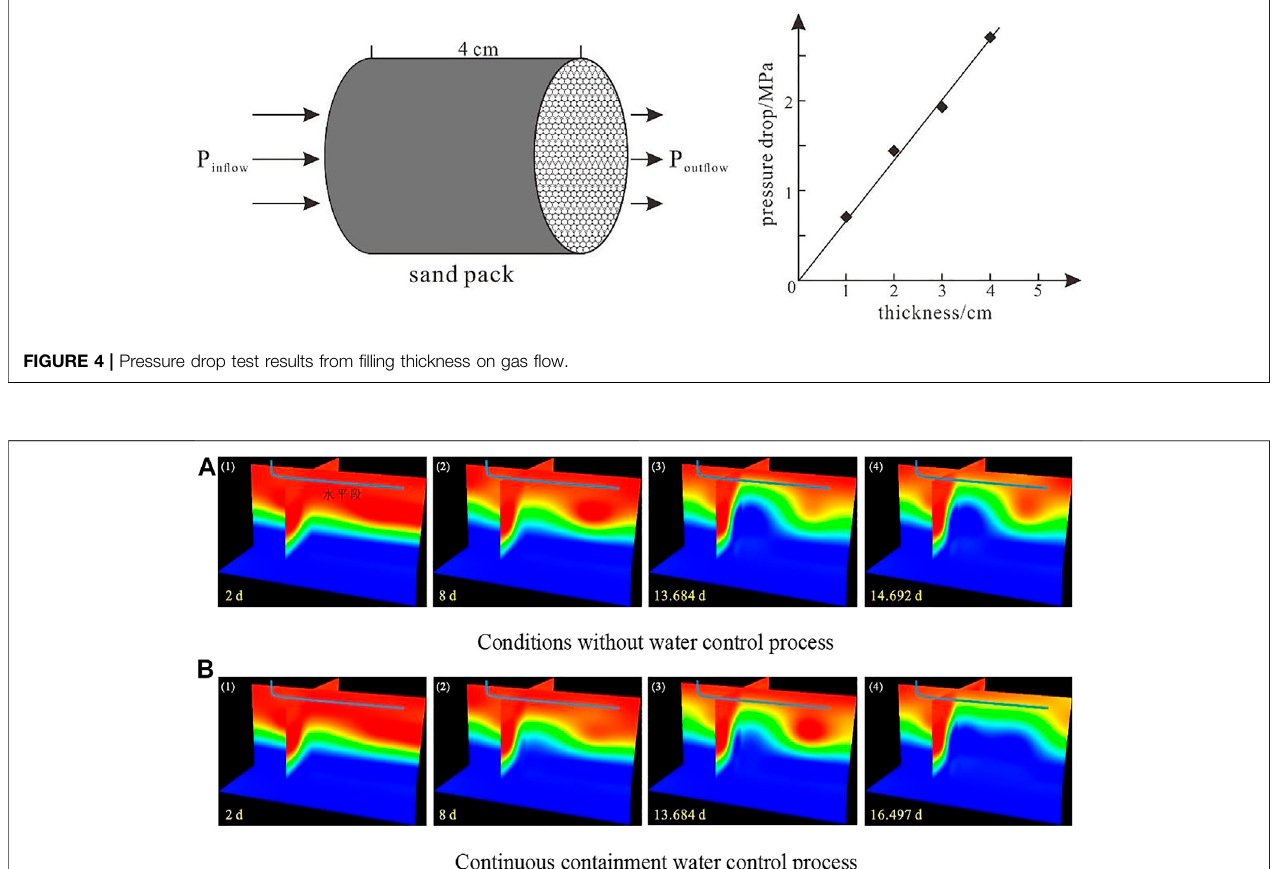
Frontiers in Earth Science |